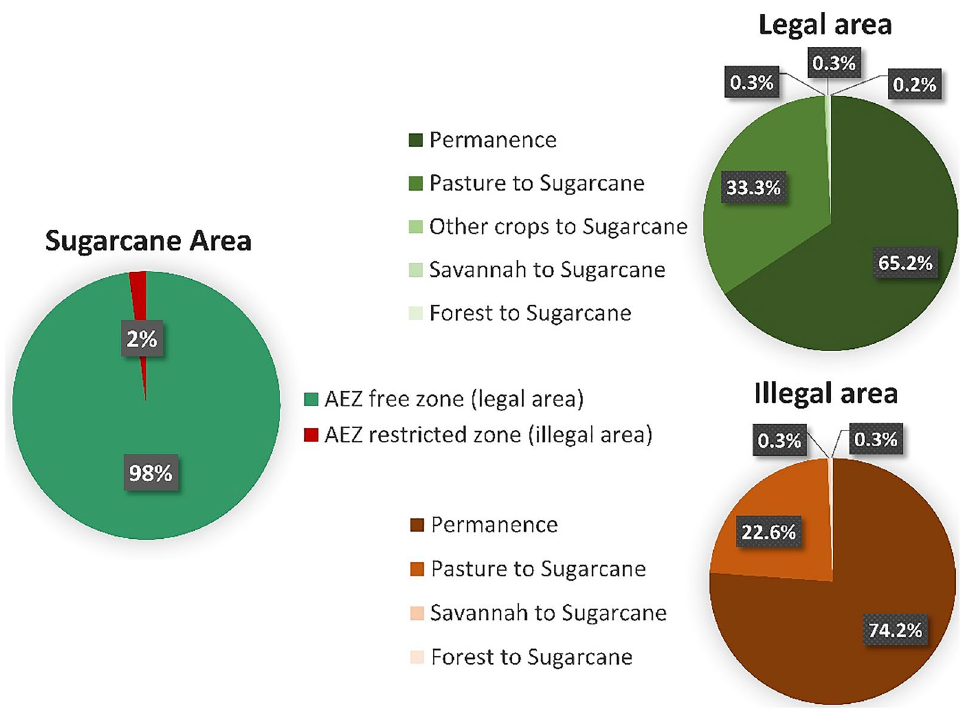
Figure 3. Sugarcane area compliance with the AEZ limits by 2030. Permanence and expansion from 2019 to 2030. Only 2% of the sugarcane area does not comply with the AEZ restrictions (illegal area). Most of this area was already sugarcane in